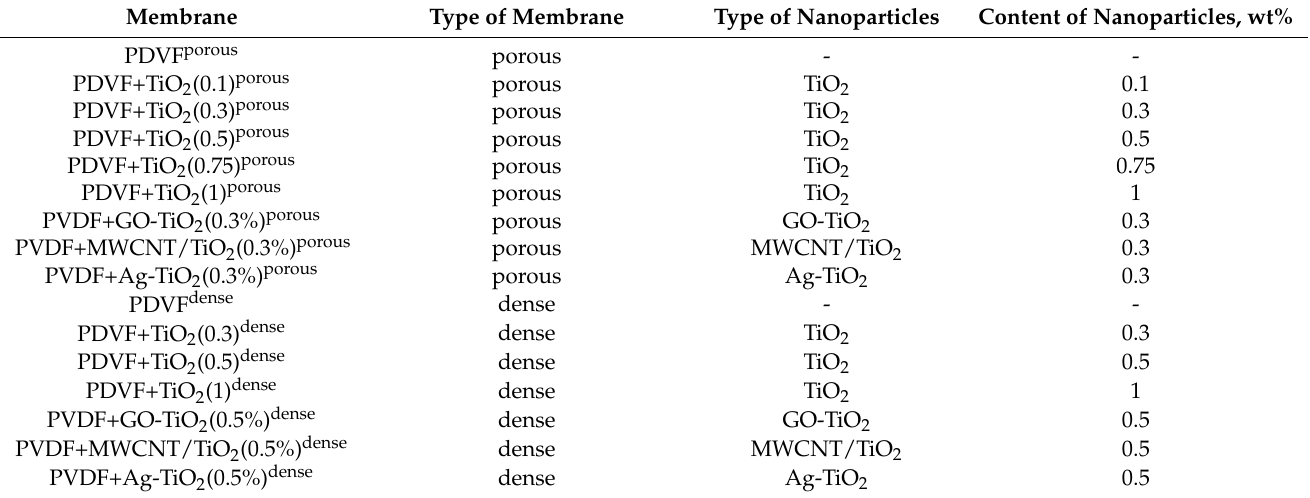
Table 1. Developed dense and porous membranes based on PVDF and PVDF/nanoparticles